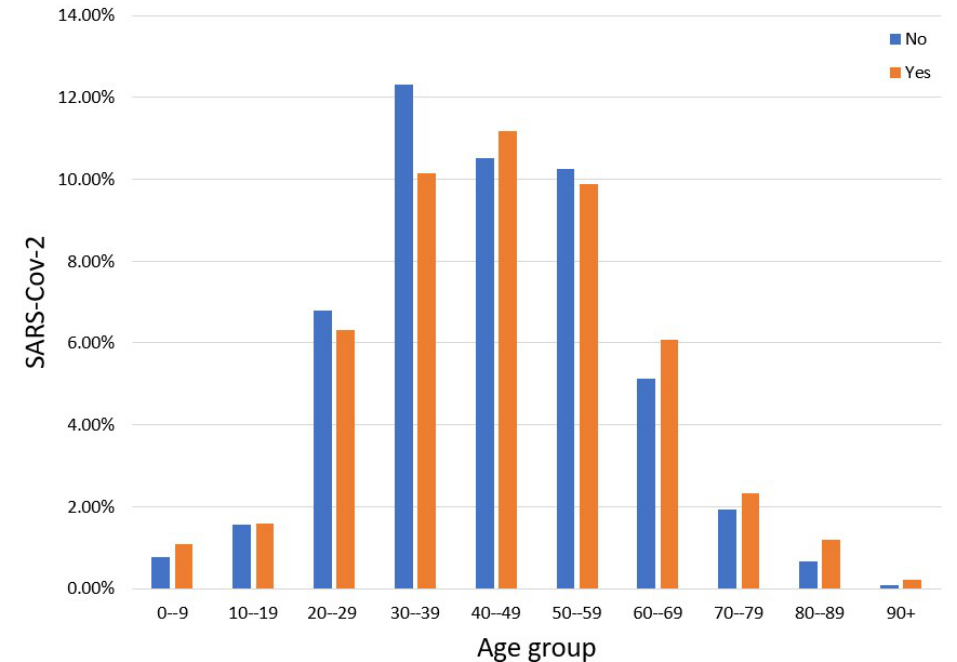
Figure 1. Percentage distribution of participants per age